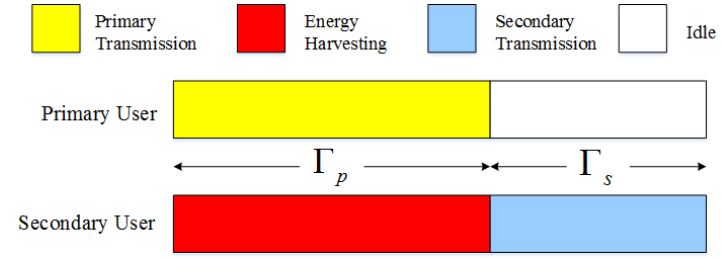
Figure 2. CR systems with energy harvesting between PU and